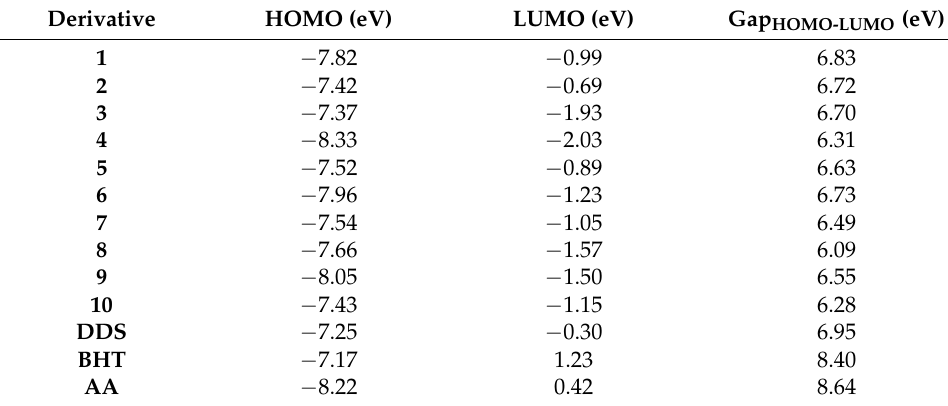
Table 4. HOMO, LUMO, and Gap HOMO-LUMO energy values.